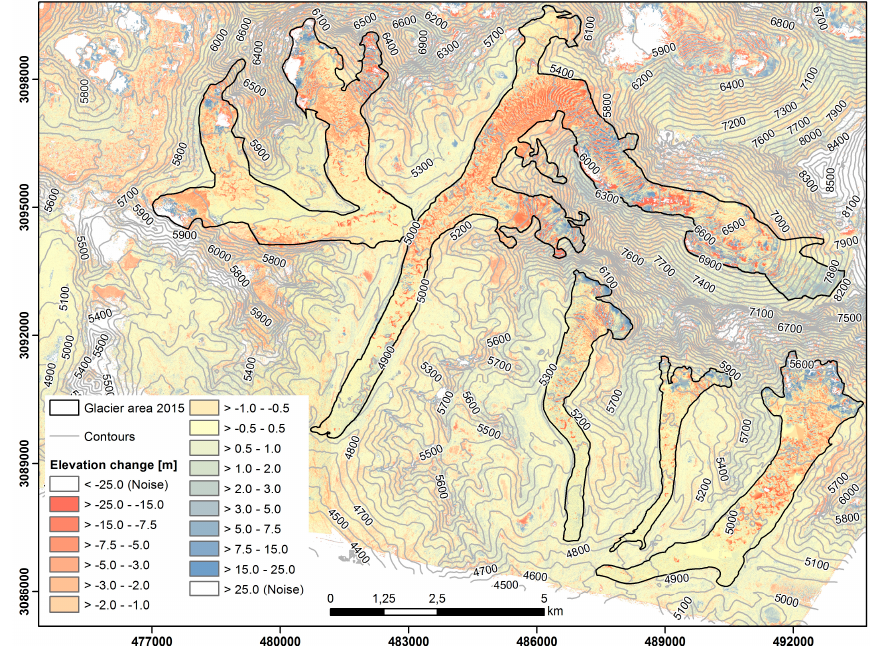
Figure 14. One-year surface elevation change of Khumbu Lhotse Nup, Nuptse, and Lhotse glaciers. UTM 45 N.